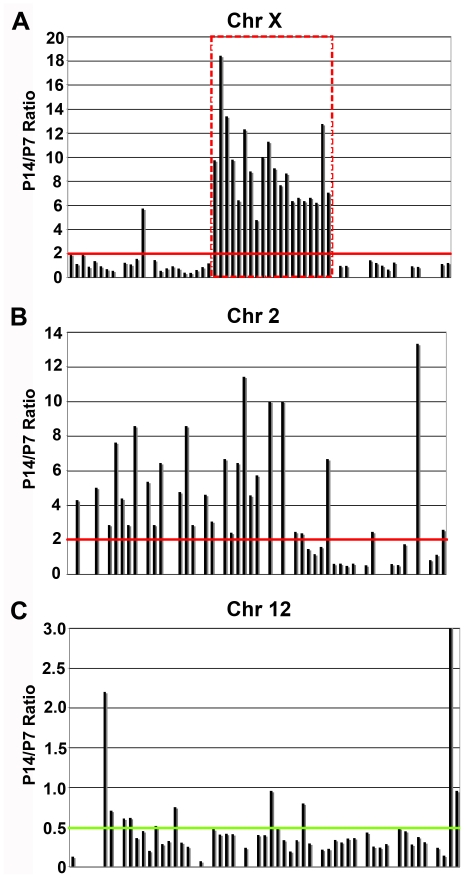
Chromosomes 2, 12, and X predominant source of pubertal-associated testis miRNAs.(A–C) Plots of miRNA expression ratios (P14/P7). (A) A large cluster miRNAs on chromosome X (ChrX) and most miRNAs on chromosome 2 (Chr2) are enriched for expression at P14 (ratio >2, red line). While those from chromosome 12 (Chr12) are enriched for expression at P7 (ratio <0.5, green line). Those on the distal arms of the X chromosome show enrichment at P7, as expected for genes showing the classical meiotic sex chromosome inactivation (MSCI) pattern of repression on P14. The large number of miRNAs on the mid-arm of chromosome X that escape this repressive process, displaying a greater abundance at P14, is in agreement with prior reports. We found a number of miRNAs falling within this cluster were ones that we had previously determined were misidentified as piRNAs in public databases (red dashed box).